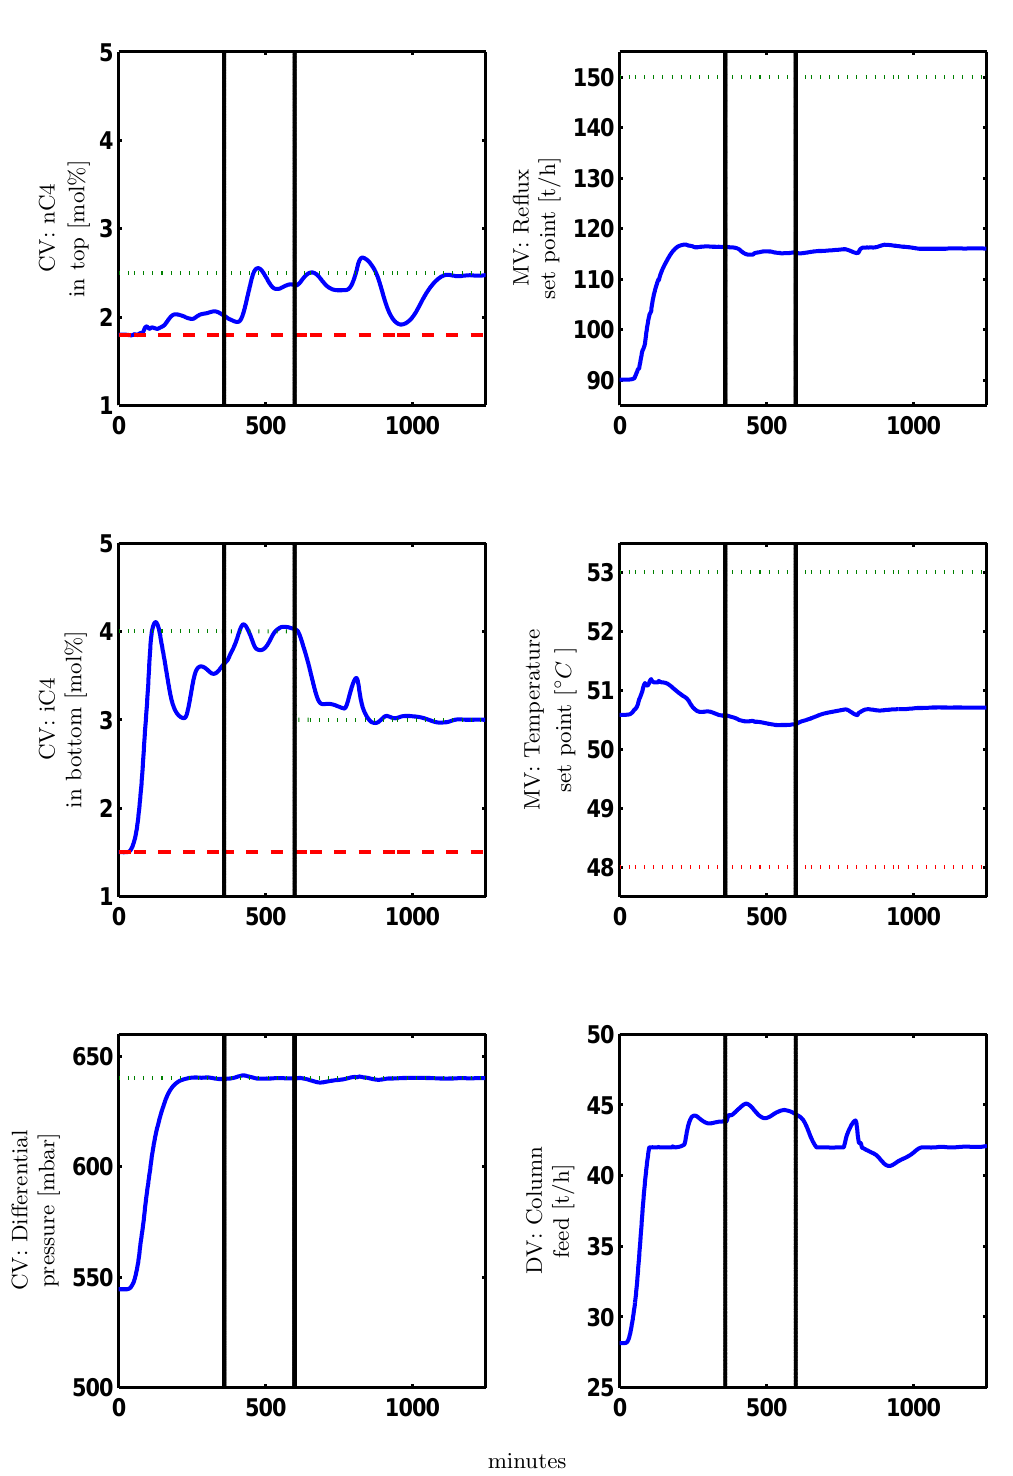
Figure 6: CVs, MVs and DV in BS100 MPC. Horizontal lines are set points (dashed) and limits (dotted).